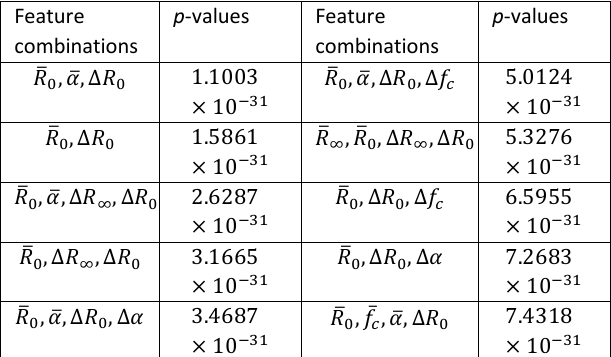
Table.1: p -values from MANOVA using EIS data taken from 1704 women for HG CIN